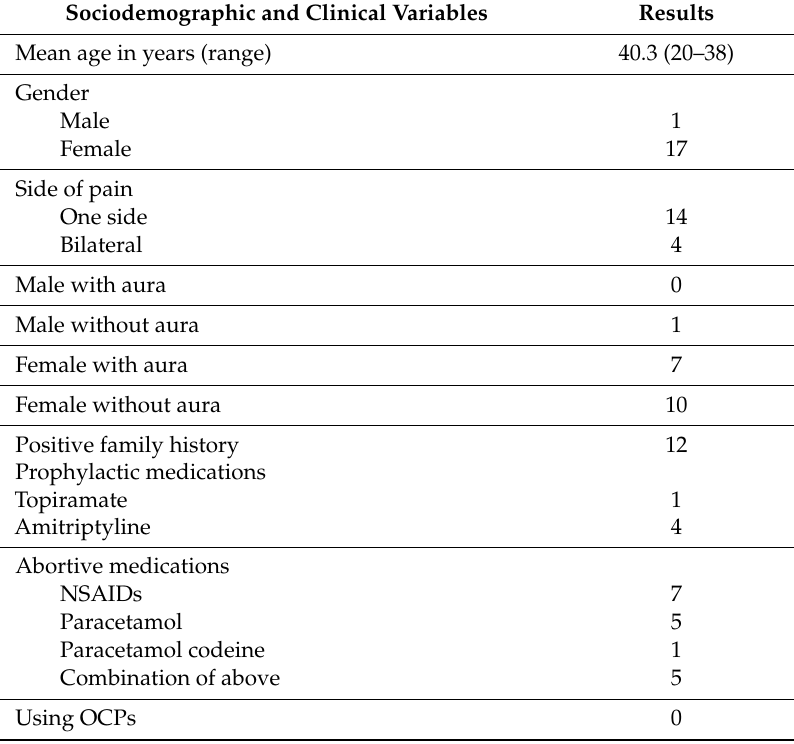
Figure 2. Flowchart of the study. S, Pf, and O refer to sham, prefrontal, and occipital blocks, respectively. Table 1. Demographic and clinical characteristics displayed as number of patients unless specified otherwise.